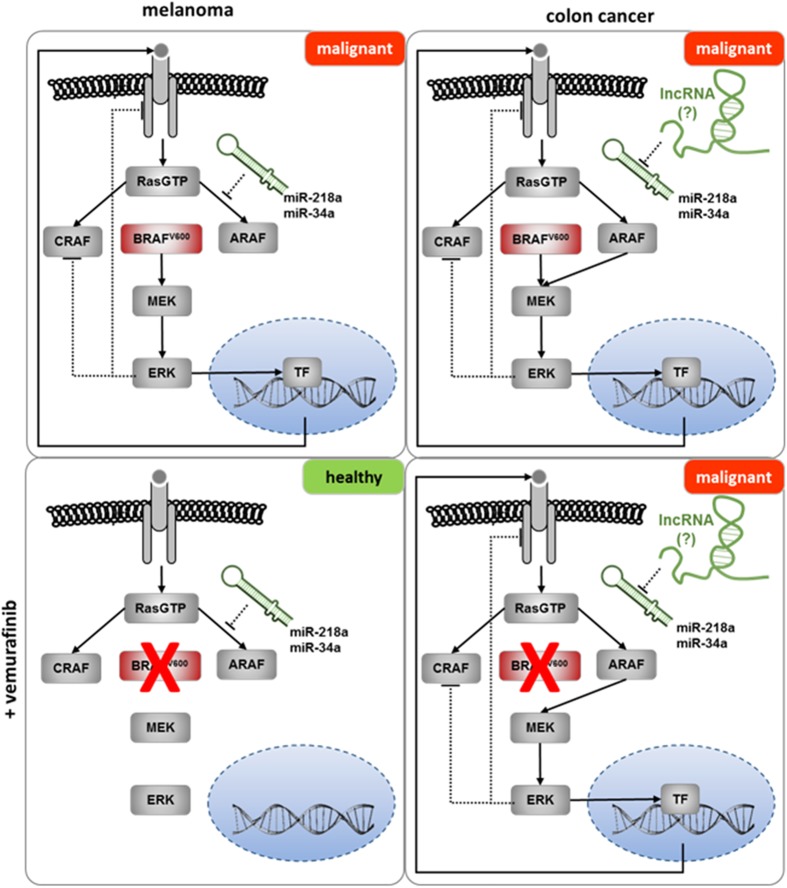
The potential role of lncRNAs in the failure of Vemurafenib in the treatment of colon cancer. Upper panel: BRAFV600E mutation induces malignant transformation in melanoma and colon cancer. Lower panel (left): treatment with Vemurafenib inhibits malignant transformation in melanoma. Bypassing the inhibition of BRAFV600E by Vemurafenib might be prevented by miRNAs (e.g., miR-34a or miR-218a) inhibiting the expression of ARAF (Lal et al., 2011; Agarwal et al., 2015). Lower panel (right): sequestering of the ARAF controlling miRNA(s) by lncRNAs in colon cancer enables the bypass of Vemurafenib inhibition, resulting in malignant transformation.